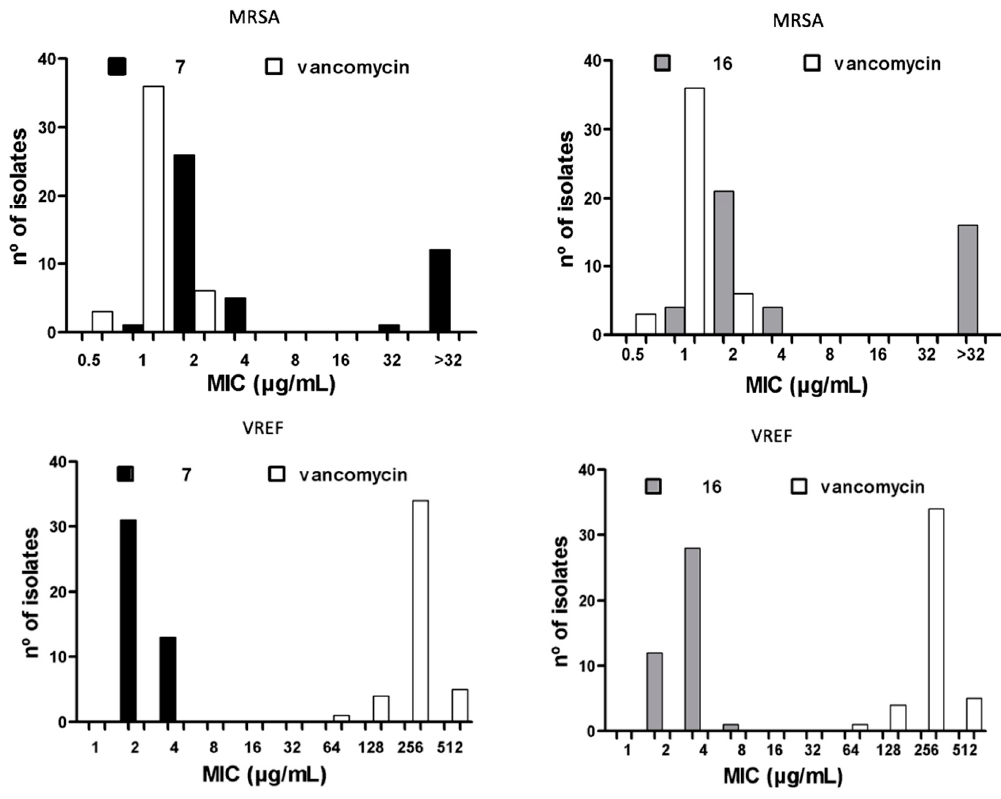
Figure 3. MIC 90 histograms for compounds 7 and 16 against MRSA and VREF vs vancomycin.